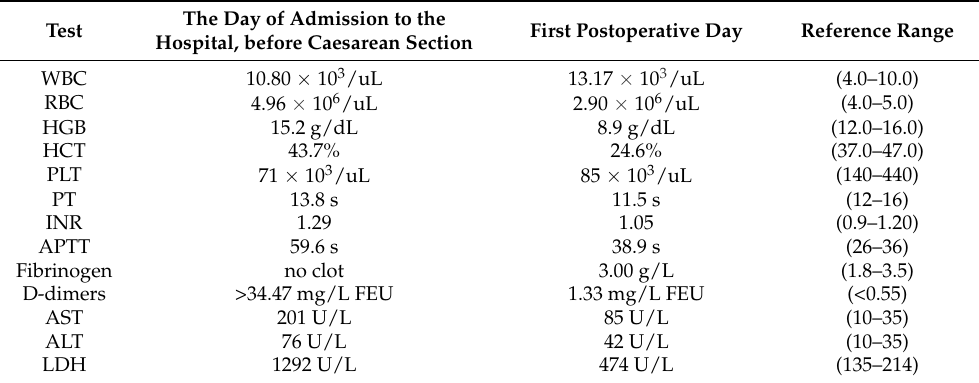
Table 1. Summary of the results of the patient’s tests at the time of admission to the hospital (before caesarean section) and on the first postoperative